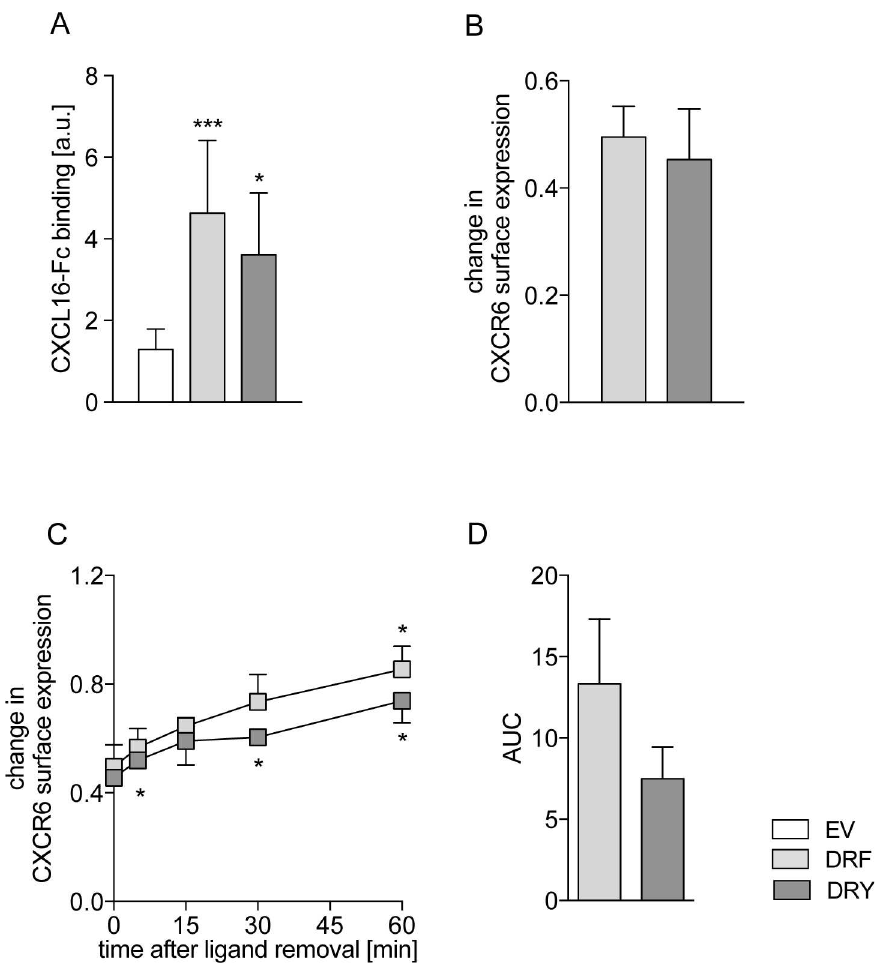
Fig 3. Rescue of the DRY motif in CXCR6 does not affect ligand binding or receptorrecycling in THP-1 cells. THP-1 cells were transduced with lentivirusencodinghumanCXCR6 variants or EV control. A: Ligand bindingof the CXCL16-Fc fusion protein (n (cid:21) 6, a.u. arbitrary units). B-D: Surface expressionof CXCR6 after receptorinternalization(B, 1 nM CXCL16-Fc for 15 min at 37˚C), and receptor recycling(C, 1 nM CXCL16-Fc for 15 min at 37˚C and subsequent removal) was analyzedby incubation with CXCL16-Fc fusion protein and FACS analysis(n = 3). Recyclingwas determined after 0, 5, 15, 30, and 60 min. Signals were expressedin relationto untreated cells (1 nM CXCL16-Fc for 15 min at 4˚C). Receptor recyclingwas further quantified as area under the curve of data shown in C (AUC, D). Statistical differences were analyzedby one-sample t-test (B, hypothetical value 1) or Student’s t-test (A, C and D). Asterisks indicate differences to control ( * p < 0.05, *** p <